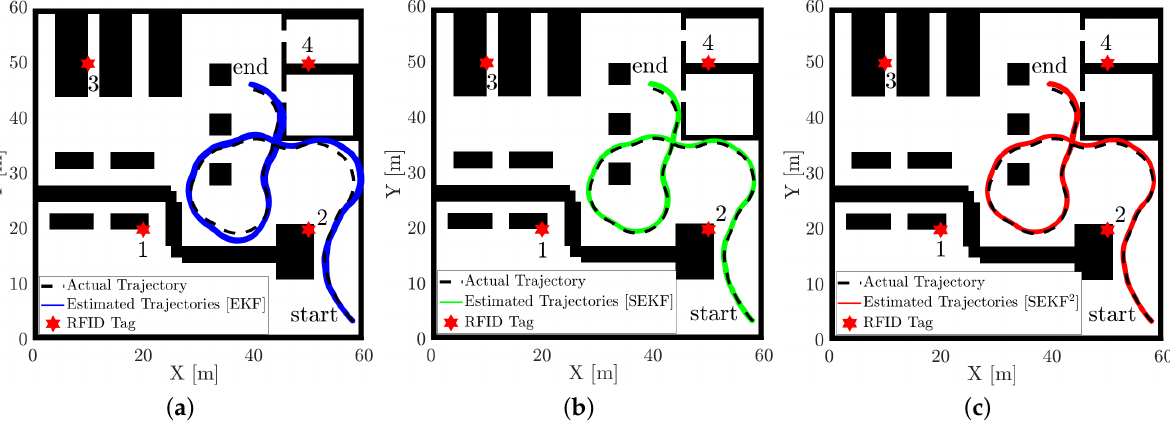
Figure 7. Sampled estimated trajectories by ( a ) EKF, ( b ) SEKF and ( c ) SEKF 2 based on the four RFID tags reported in the figure with star